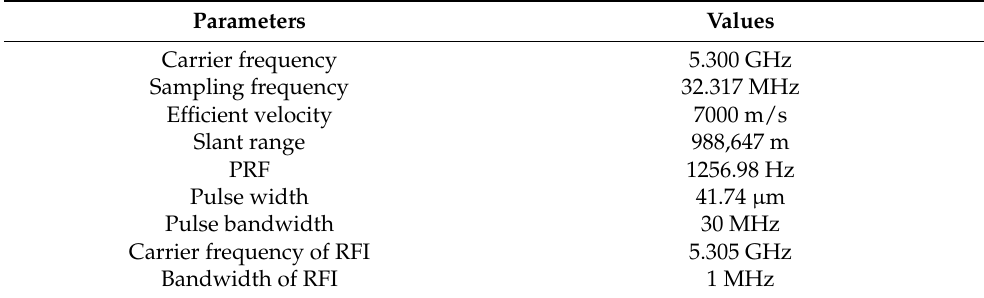
Table 1. Main parameters of measured SAR data and simulated RFI.